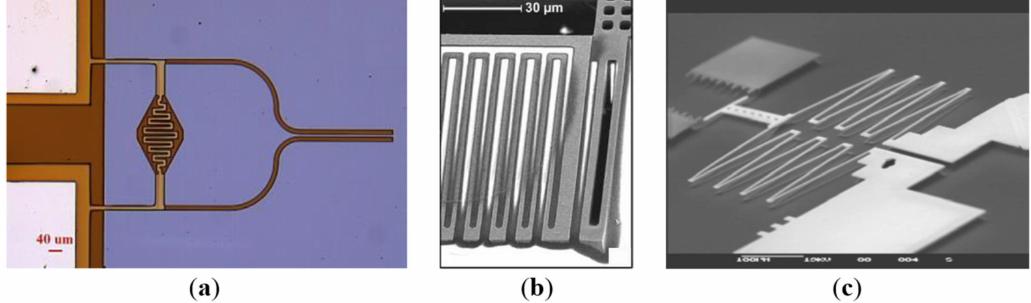
Figure 11. Unconventional electrothermal actuation mechanisms: ( a ) microgripper with expanding bar actuator [128]; ( b ) microgripper based on silicon-polymer stack [129]; ( c ) microspring